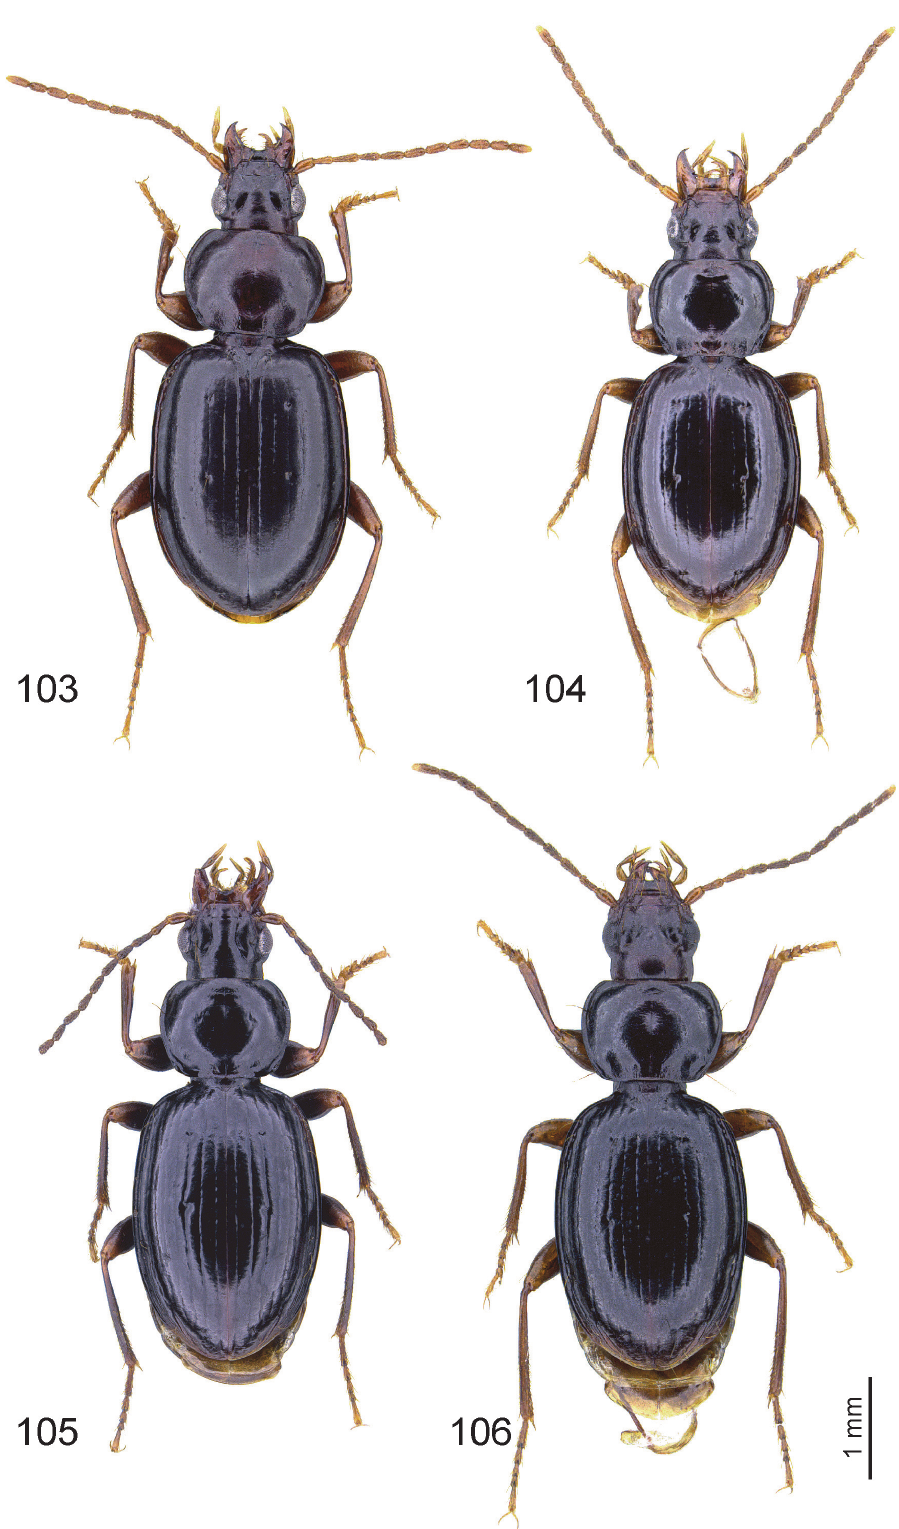
Figs 103–106. Trechus spp., habitus. 103 . T. haggei sp. nov., paratype, ♂. 104 . T. tragelaphus sp. nov., holotype. 105 . T. nigrifemoralis , sp. nov., holotype. 106 . T. balesilvestris , sp. nov.,